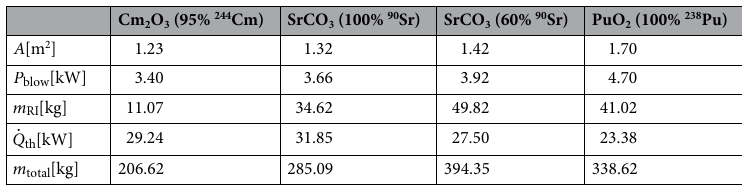
Table 11. Comparison of the most important calculation results for all investigated radioisotopes; for chosen balanced cases and optimized temperature swings; full corresponding data in Supplementary